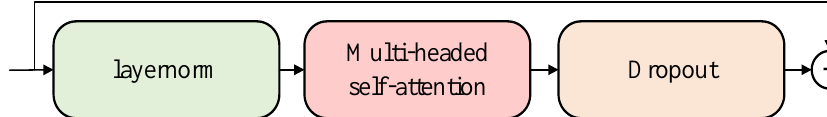
Figure 9. Multi-head self-attention module.